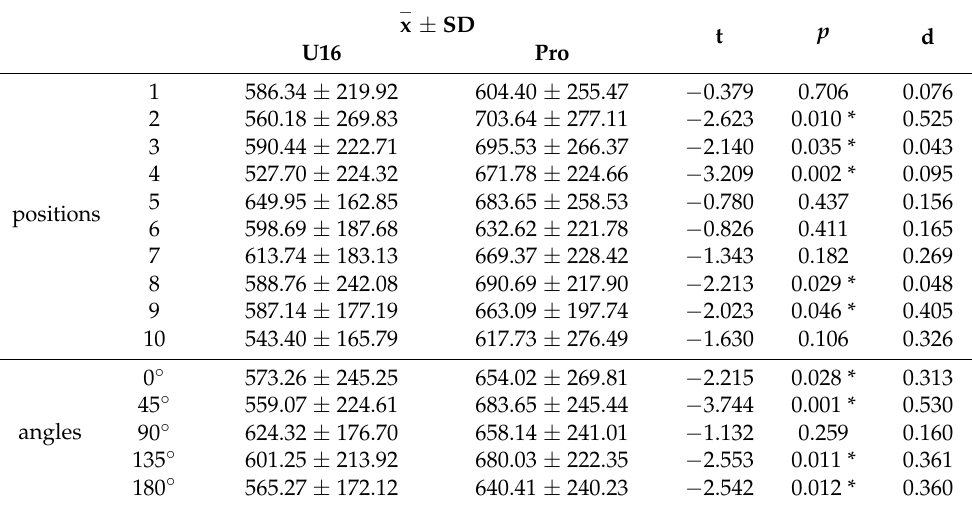
Table 3. Between-group comparison for total fixation duration before shot, according to position and angle (times in milliseconds—ms).